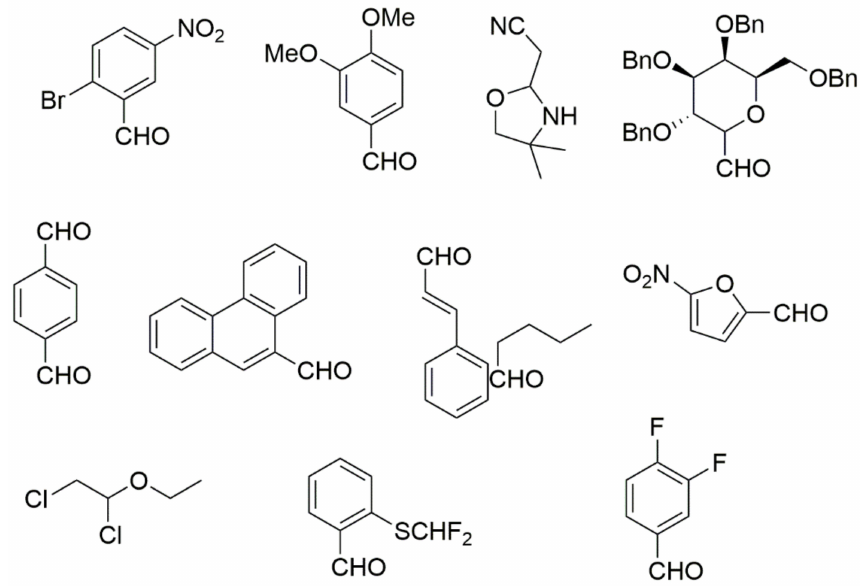
Figure 5. Classic aldehyde precursors used for Biginelli